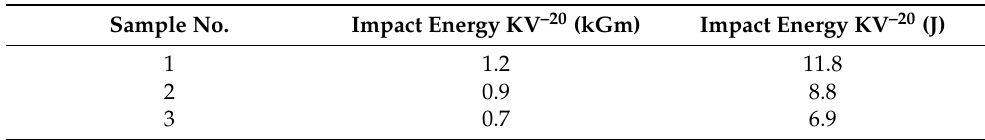
Table 9. Results of the Charpy impact strength tests of samples from the handy-size bulk carrier 30185